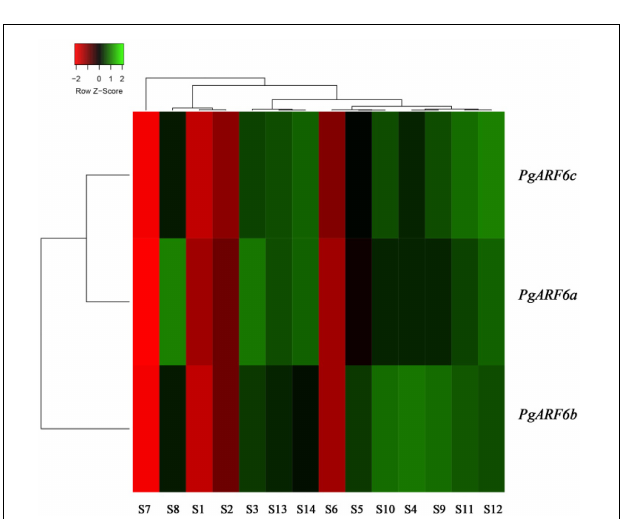
FIGURE 5 | PgARF6 expression heatmap in different organs of pomegranate. S1, “Baiyushizi” inner seed coat; S2, “Tunisiruanzi” inner seed coat; S3, flower; S4, leaf; S5, root; S6, inner seed coat; S7, outer seed coat; S8, pericarp; S9, bisexual flower I; S10, functional male flower I; S11, bisexual flower II;